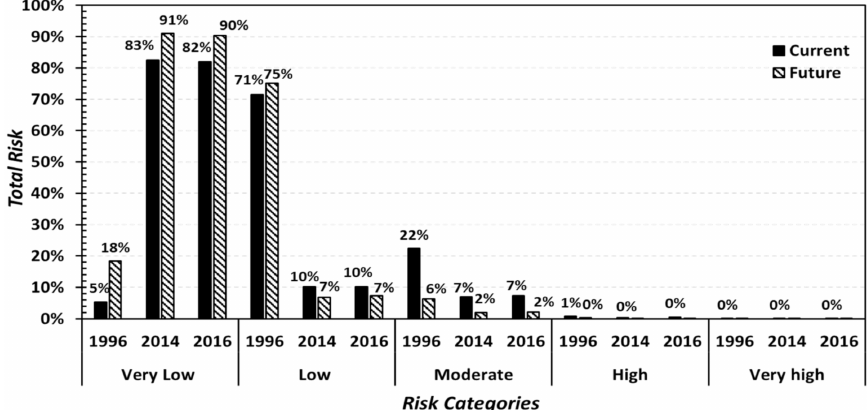
Figure 12. Current and future total risk in